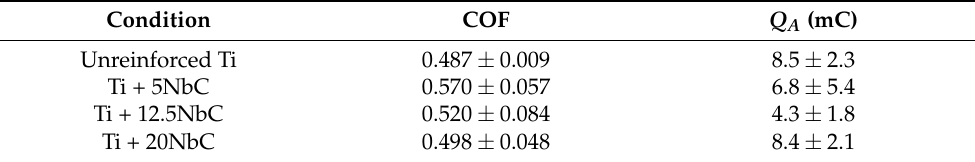
Table 5. Average values of COF and anodic charge ( Q A ) estimated during sliding performed under +0.5 V vs. Ag/AgCl.